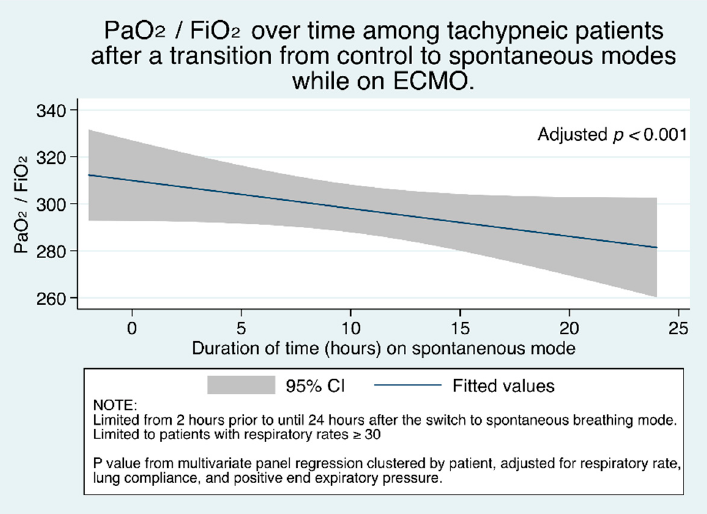
Figure 5. PaO 2 /FiO 2 ratio (95% CI) over time among tachypneic patients (respiratory rate ≥ 30).